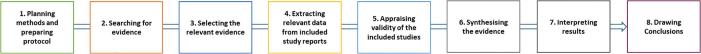
Steps of a Systematic Review.